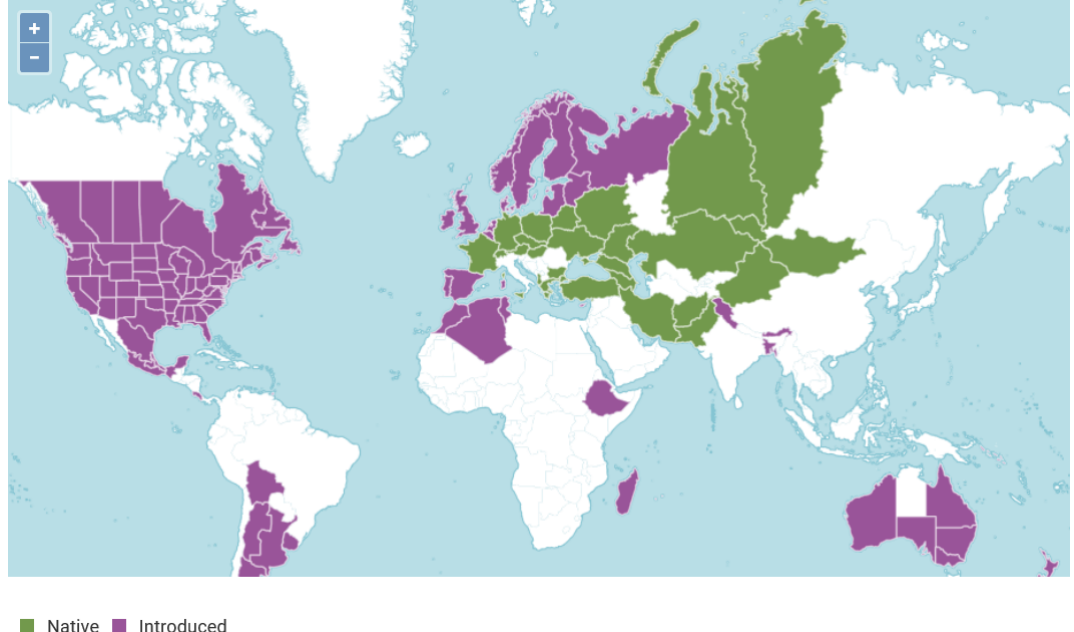
Figure 1. Distribution of cultivation of Asparagus officinalis around the world. The origin is believed to be eastern Mediterranean, however, it grows also in central Europe, the Caucasus and western Asia. It was brought centuries ago to North America, Northern Europe and parts of South America, North Africa and Australia. c (cid:13) Copyright 2017 World Checklist of Selected Plant Families. http: //creativecommons.org/licenses/by/3.0